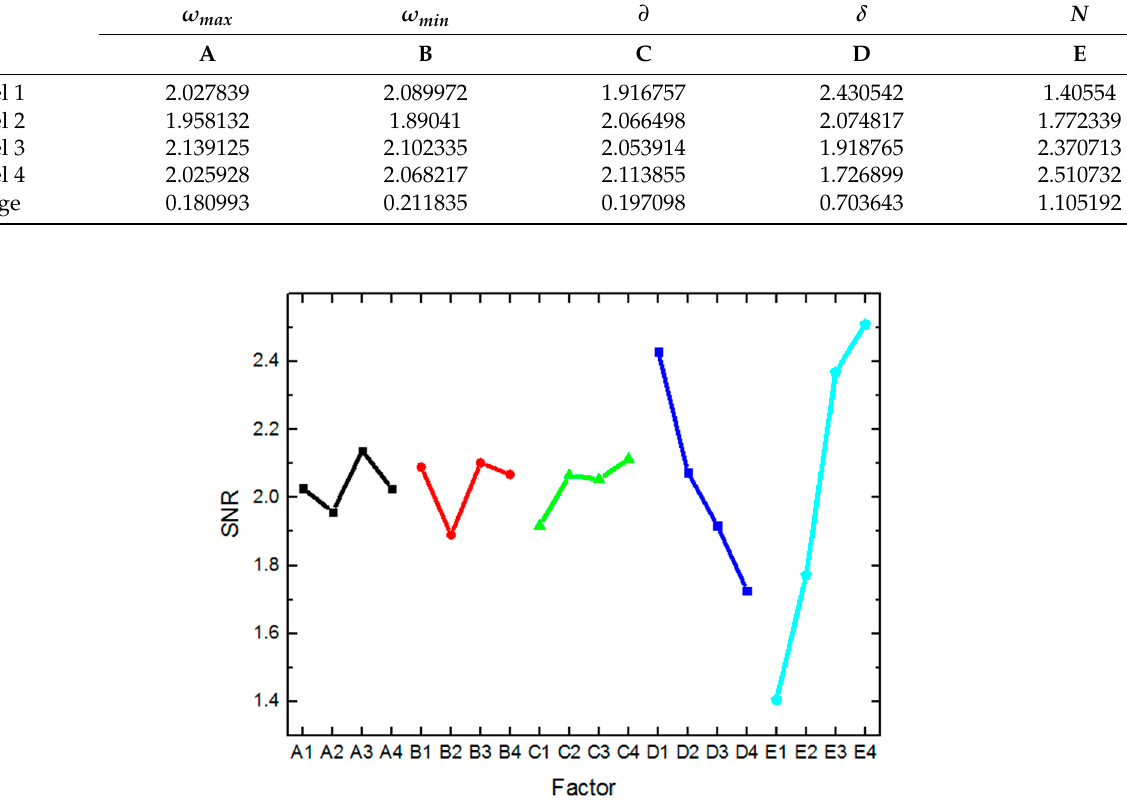
Figure 4. Factor response figure.